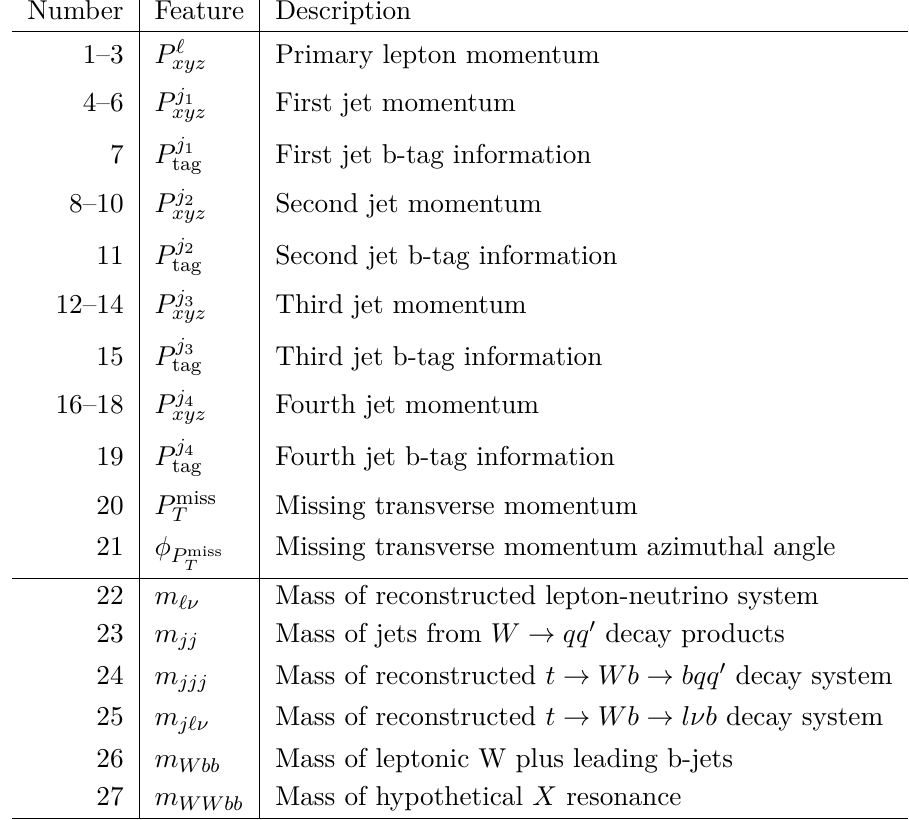
Table 1 . List of the 27 features of signal and background events in the HEPMASS dataset. The first 21 are low-level features, the last 6 are higher-level ones produced by combining the low-level features into physics-motivated observables. See the text for more